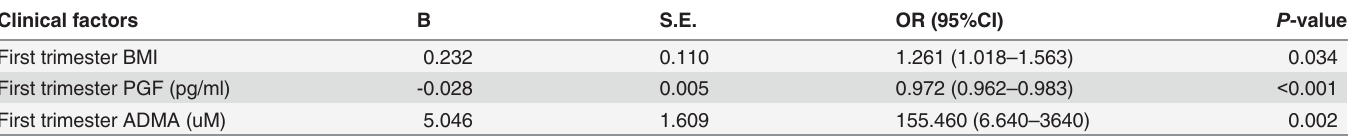
Table 2. Multivariate logistic regression of factors predicting preeclampsia. Clinical factors